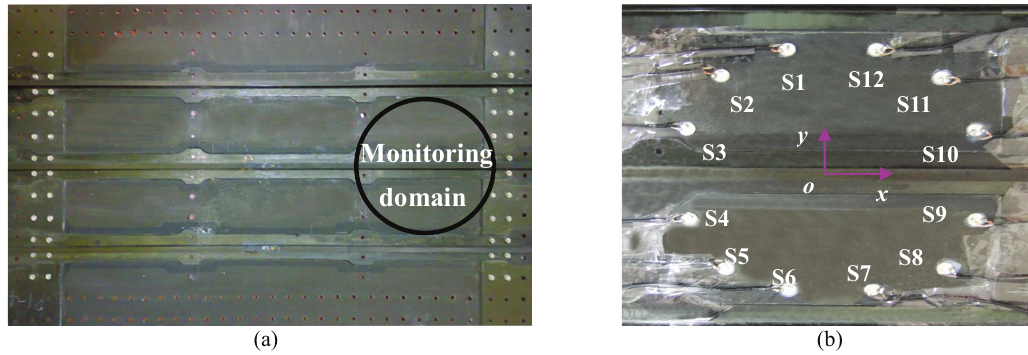
Fig. 10. Stiffened composite panel and transducer array: (a) Stiffened panel; (b) Monitoring